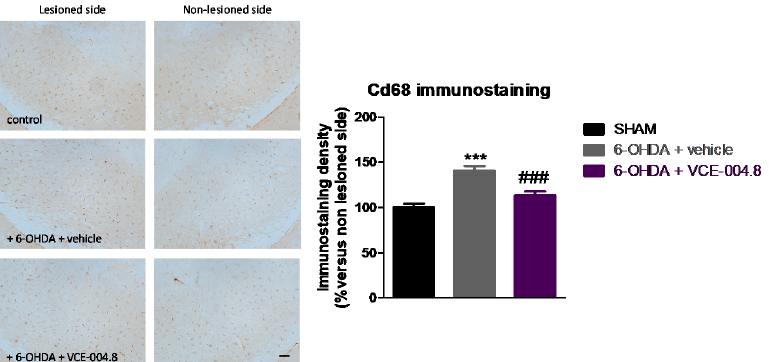
Figure 4. Intensity of the immunostaining for Cd68, a marker of microglia and infiltrated macrophages, measured in a selected area of the substantia nigra pars compacta of control (sham) mice and unilaterally 6-OHDA-lesioned animals treated with VCE-004.8 (20 mg/kg) or vehicle (Maisine CC/corn oil) given orally. Treatments were daily and prolonged for 2 weeks. Data corresponded to percentage of the ipsilateral lesioned side versus contralateral non-lesioned side at 24 h after the last dose and were expressed as means ± SEM of more than 5 animals per group. They were analyzed by one-way ANOVA followed by the Bonferroni test (*** p < 0.005 versus sham; ### p < 0.005 versus 6-OHDA + vehicle). Representative immunostaining images for each experimental group are shown in the left panels (scale bar = 100 µm).